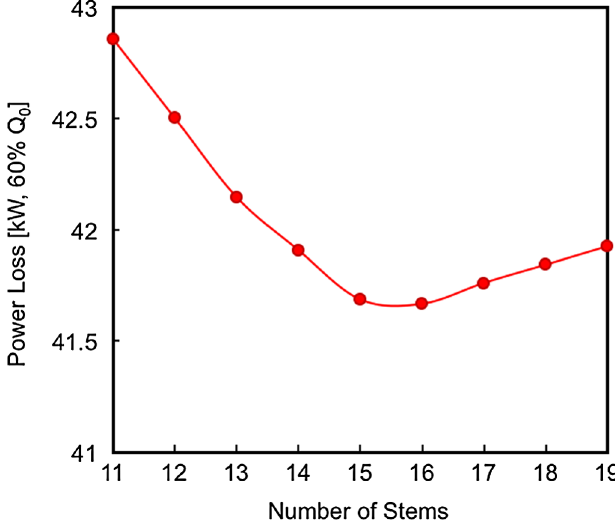
FIG. 6. A plot of the power loss as a function of the number of stems in the cavity. Wall loss is normalized with respect to the interrod voltage (Kilpatrick factor: